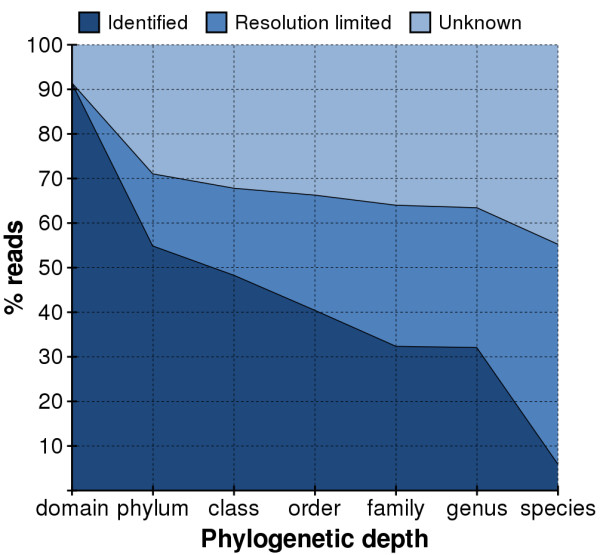
Read resolution within phylogenetic tree for combined samples. Combined categorization of the reads in all six samples into their proportion of reads identified (dark blue)/resolution limited (medium)/unknown (light).